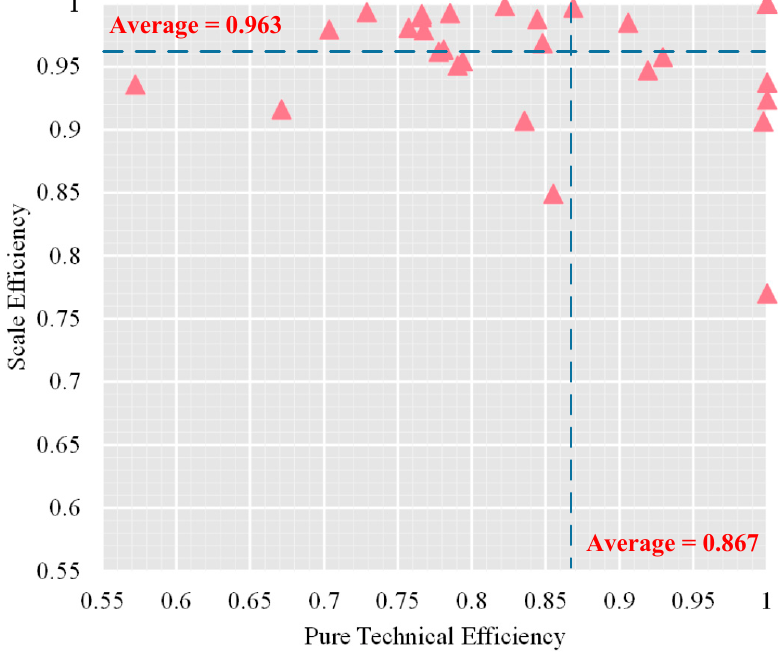
Figure 6. The pure technical efficiency and scale efficiency of 34 Chinese LED energy enterprises in